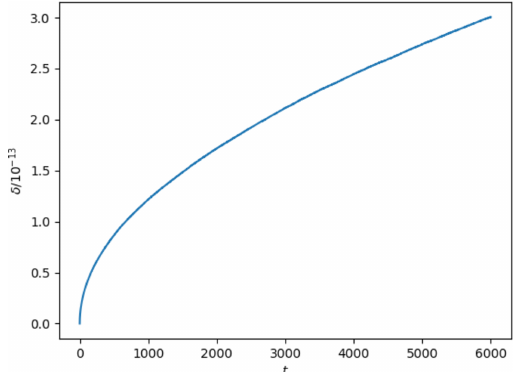
Figure 28 . Examples of how the deviation parameter evolves during both radial and full 3D dynamics. Both of these show the evolution of vortons constructed in parameter set A with Q = 749 and N = 50 . It remains incredibly small during radial dynamics and grows smoothly. This is in contrast to the 3D dynamics where it is nearly 10 orders of magnitude larger (although still within acceptable limits) and varies more wildly, growing particularly quickly after the vorton starts to break apart at t ≈ 750 , but remaining sufficiently small before this point.